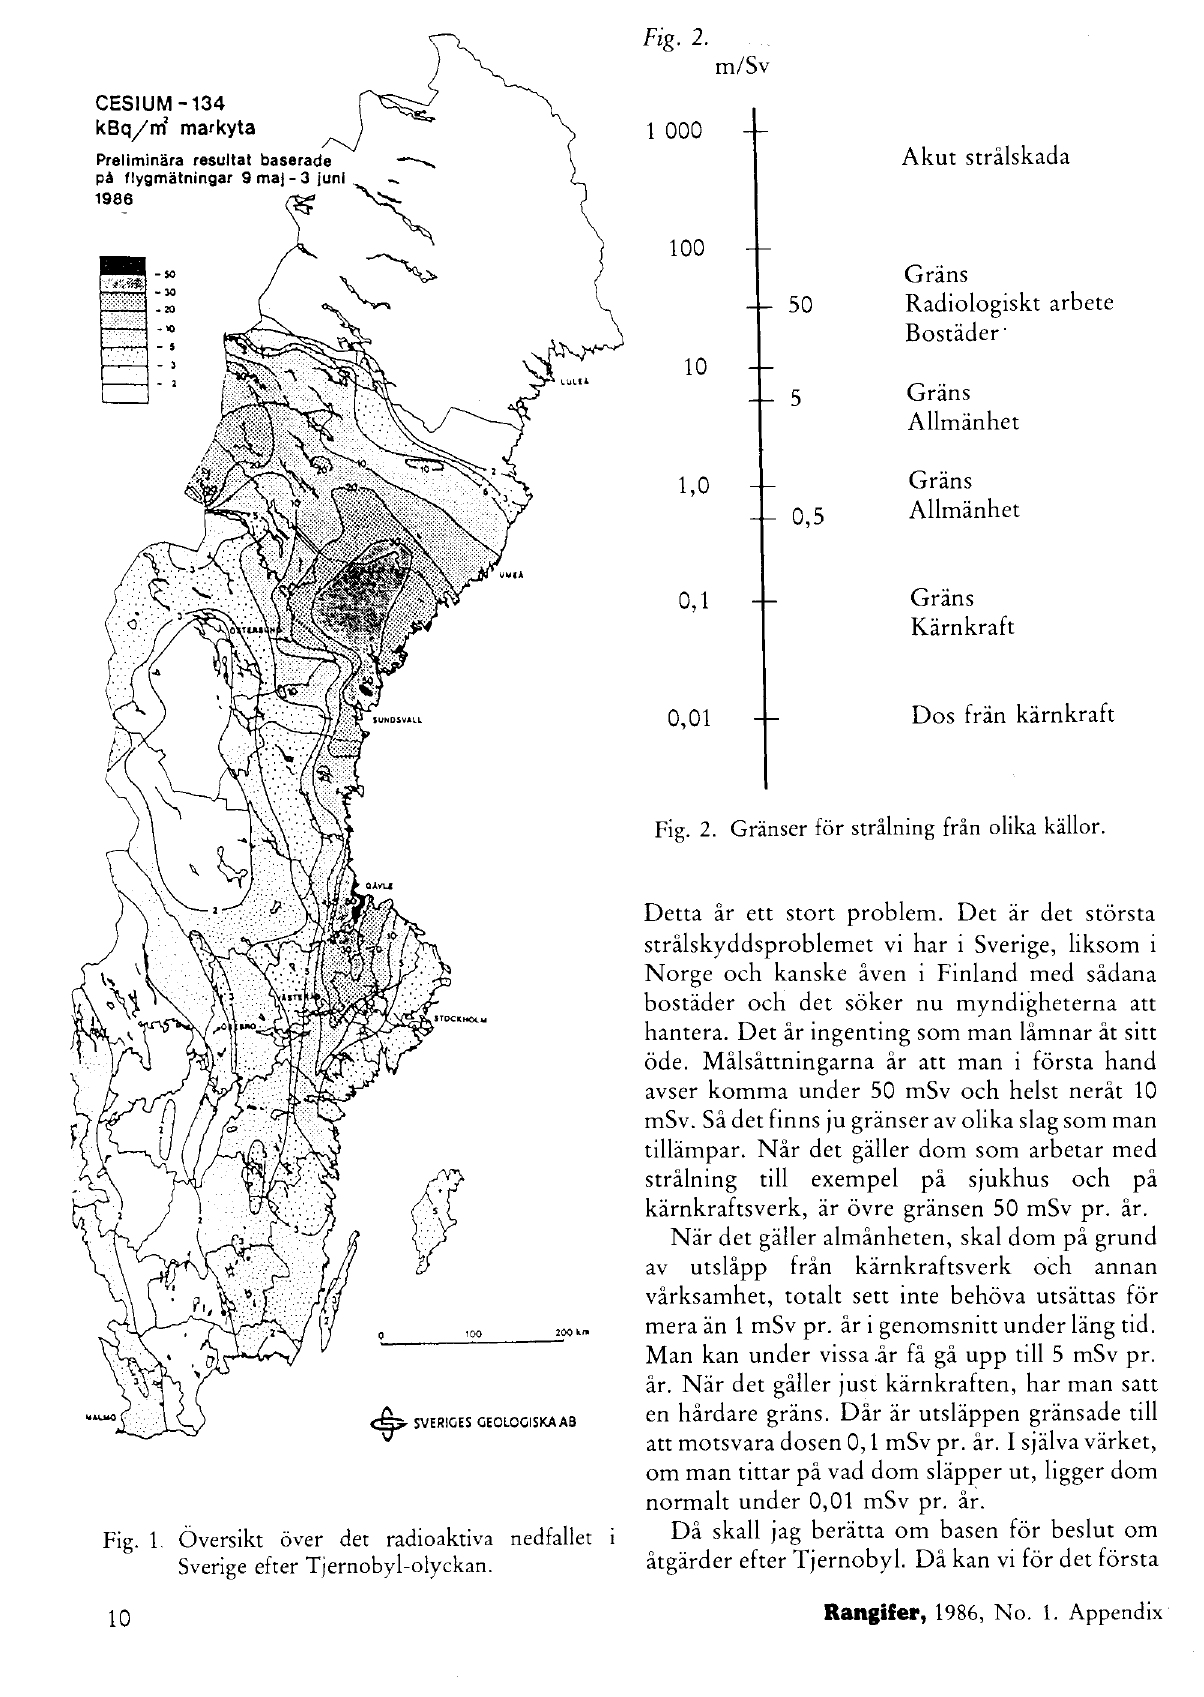
Fig. 2. Gränser fôr strålning från olika